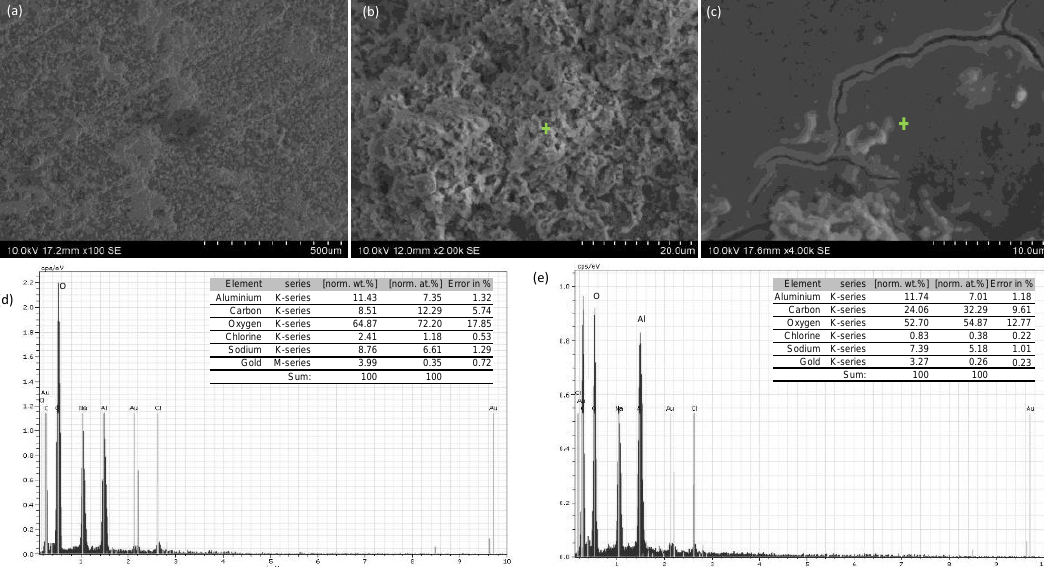
Figure 5. SEM images of the surface of the Al12Si / SiC coating after 168 h of immersion in 3.5 wt.% NaCl: ( a ) general view of surface; ( b ) and ( c ) details of the morphology of the corrosion products formed; general view; ( d ) and ( e ) EDS analysis of zones marked in ( b ) and ( c ), respectively.